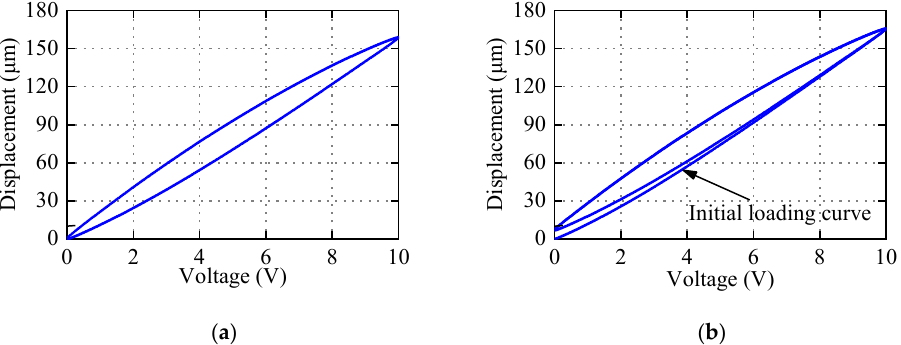
Figure 12. Two cases of comparative experiment. ( a ) Case 1: the initial loading curve is not considered; ( b ) Case 2: the initial loading curve is considered.